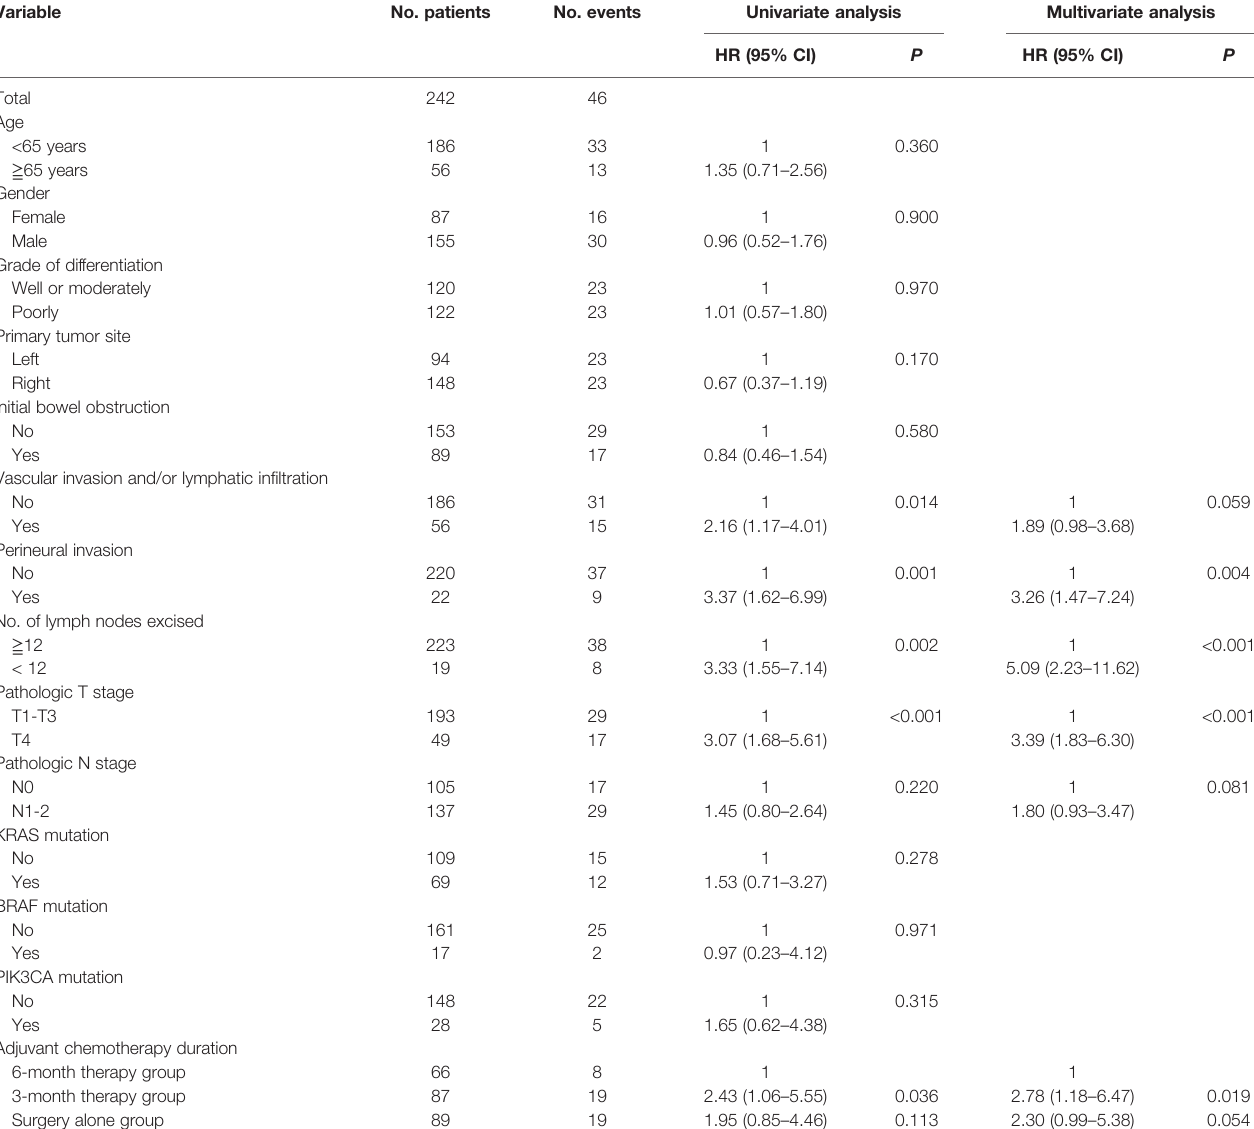
TABLE 2 | Univariate and multivariate Cox proportional hazards regression model for disease-free survival.